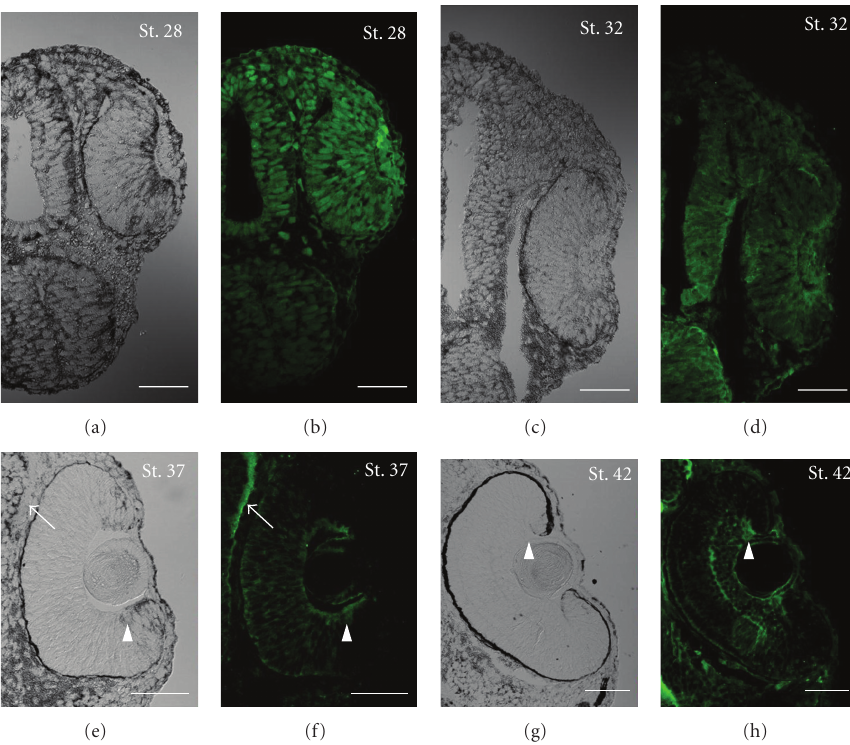
Figure 1: Immunoreactivities for HN1 protein in newt retinas at early stages of eye development. The developmental stages of embryos were determined as shown in, Materials and Methods. Nomarski images (a, c, e, and g) and immunoreactivity (b, d, f, and h) in transverse sections of stage 28 (a, and b) and stage 32 (c, and d) embryos, and in coronal sections of stage 37 (e, and f) and stage 42 (g, and h) embryos. The fibrillary fluorescent signal was observed, corresponding to the region outside RPE layer from the bright-field observation (arrows in Figures 1(e) and 1(f)). All scale bars indicate 100 μ